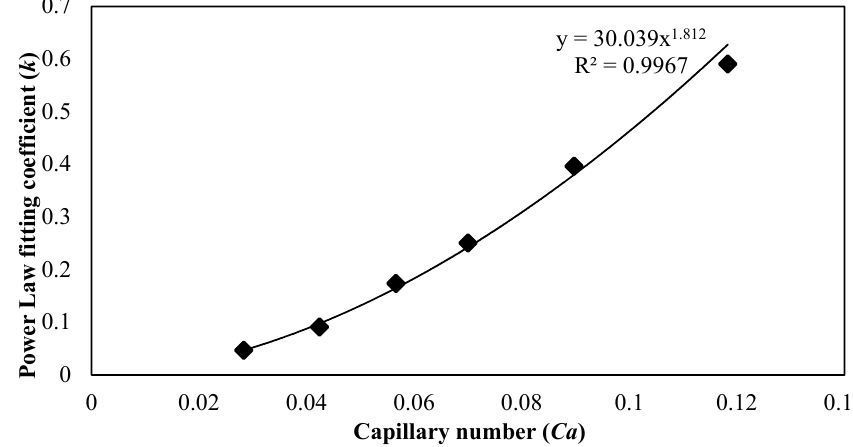
Figure 6. Power law fitting coefficient (k) plotted against capillary number.